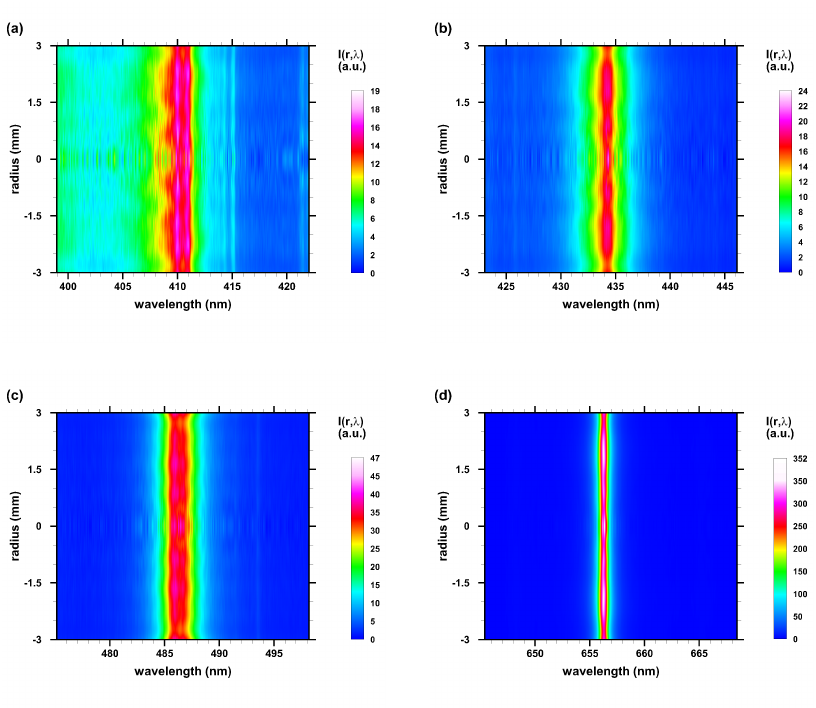
Figure 8. Abel-inverted Balmer-series hydrogen lines at 3.25- µ s time delay, 0.025- µ s gate. ( a ) H δ , ( b ) H γ , ( c ) H β , and ( d ) H α